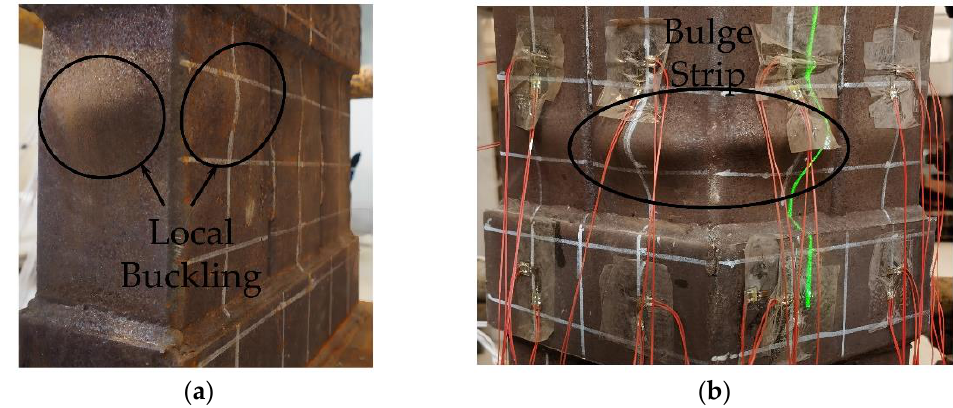
Figure 10. Bulging deformation ( a ) local buckling of HT-1; ( b ) bulge strip of